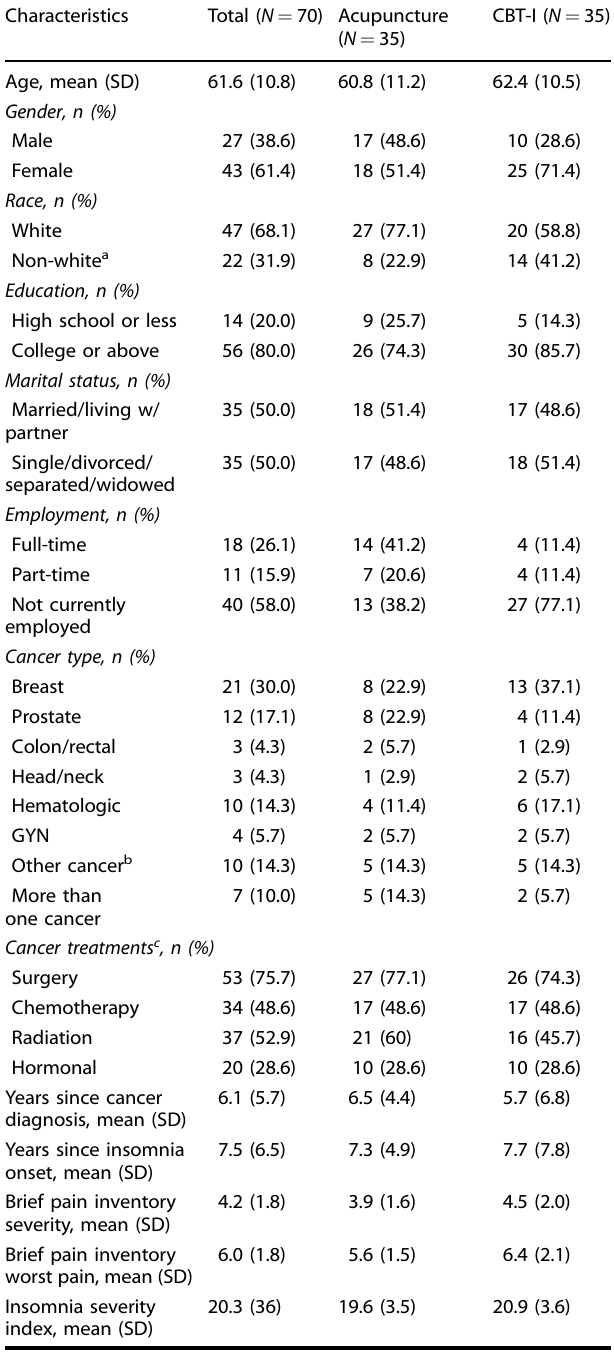
Table 1. Demographics and clinical characteristics of participants.